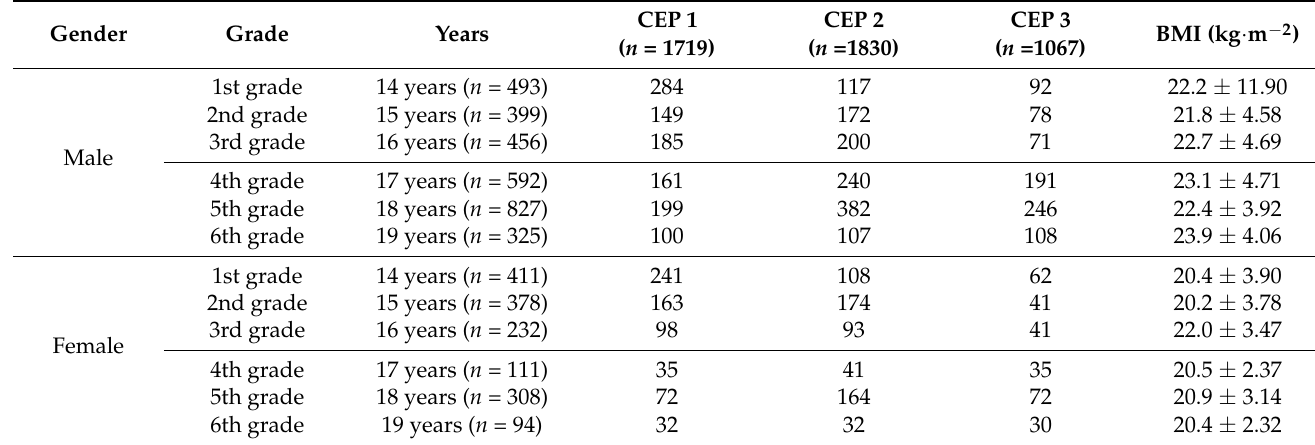
Table 1. Sample size by gender and grade.